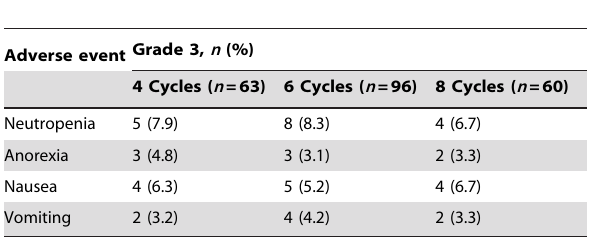
Table 3. Adverse events observed during four cycles of